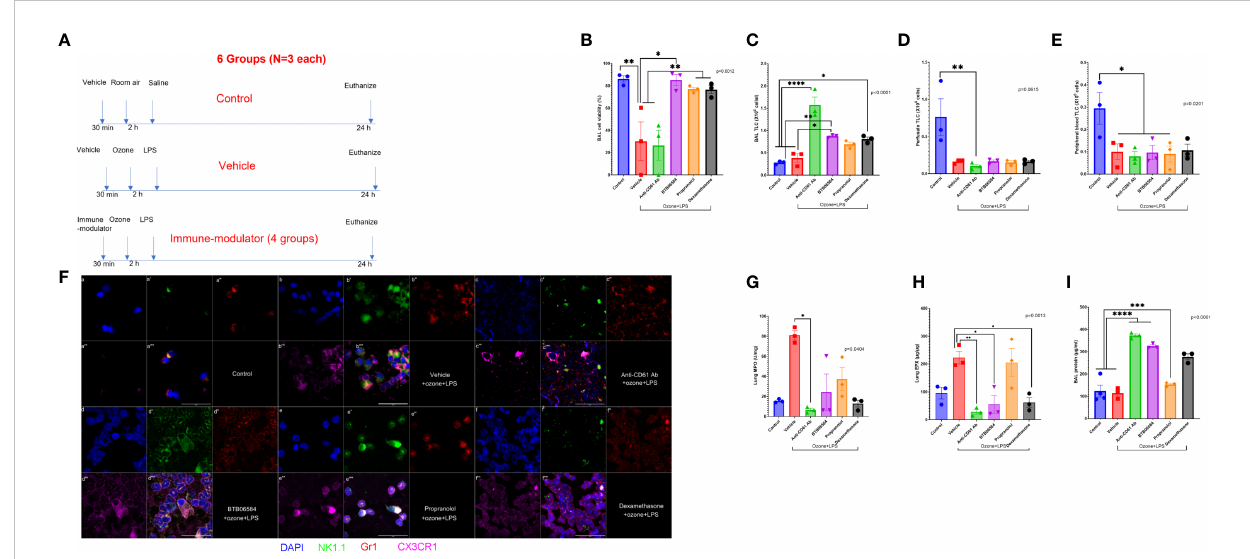
FIGURE 1 Effect of combined ozone and LPS exposure in mice: (A) Experiment design of the study showing treatments in 6 different groups with N=3 in each group. The fi rst group represents control group with 0.001% DMSO administered intraperitoneally (IP) 30 minutes before housing mice in cage where they breathed room air for 2 h. After 2 h, mice were lightly anesthetized with IP ketamine/xylazine and instilled with 50 m l sterile saline. The second group represents treatment group with 0.001% DMSO administered intraperitoneally (IP) 30 minutes before housing mice in custom cage where they breathed 0.005 ppm ozone for 2 h. After 2 h, mice were lightly anesthetized with IP ketamine/xylazine and instilled with 50 m g/50 m l bacterial lipopolysaccharide (LPS) from E. coli strain 055:B5. The third to sixth groups represent treatment group with immune-modulators (1 mg/kg anti-CD61 antibody (clone 2C9.G2), 1 mg/kg BTB06584, 1 mg/kg propranolol and 0.1 mg/kg dexamethasone) administered intraperitoneally (IP) 30 minutes before housing mice in custom cage where they breathed 0.005 ppm ozone for 2 h. After 2 h, mice were lightly anesthetized with IP ketamine/xylazine and instilled with 50 m g/50 m l bacterial lipopolysaccharide (LPS) from E. coli strain 055:B5. All mice were euthanized at 24 h time- point to collect peripheral blood, vascular perfusate, bronchoalveolar lavage (BAL), right lung for biochemical and chemokine analysis and left lung fi xed in-situ with 4% paraformaldeyde, for cryosectioning and H&E histology. (B) Percent BAL cell viability assessed with trypan blue exclusion, across the 6 groups, ANOVA p=0.0012, (C) BAL total leukocyte counts (TLC) expressed as 10 6 cells, ANOVA p<0.0001, (D) Lung vascular perfusate TLC expressed as 10 6 cells, Kruskal-Wallis p=0.0615, (E) Peripheral blood TLC expressed as 10 6 cells, ANOVA p=0.0201. (F) BAL cell immune- fl uorescent staining of control, and the 4 treatment groups, for nucleus with DAPI shown in blue (a, b, c, d, e, f), NK1.1 shown in green (a ’ , b ’ , c ’ , d ’ , e ’ , f ’ ), Gr1 shown in red (a ’’ , b ’’ , c ’’ , d ’’ , e ’’ , f ’’ ), CX3CR1 shown in fuschia (a ’’’ , b ’’’ , c ’’’ , d ’’’ , e ’’’ , f ’’’ ). The merged panels are shown in the sub-parts a ’’’’ , b ’’’’ , c ’’’’ , d ’’’’ , e ’’’’ , f ’’’’ , scale = 50 m m. (G) Lung myeloperoxidase (MPO) biochemical quanti fi cation across groups expressed as U/mg of lung tissue, Kruskal-Wallis p=0.0404, (H) Lung eosinophil peroxidase (EPX) ELISA based quanti fi cation across groups expressed as m g/ m g of lung tissue, ANOVA p=0.0013, (I) BAL protein content across groups expressed as m g/ml, ANOVA p<0.0001. Signi fi cance level was set at p<0.05. * represents p<0.05, ** p<0.01, *** p<0.001, and ****